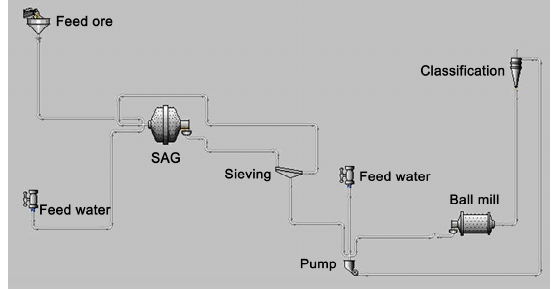
Figure 5. SAG-ball mill circuit for the JKSimMet platform.